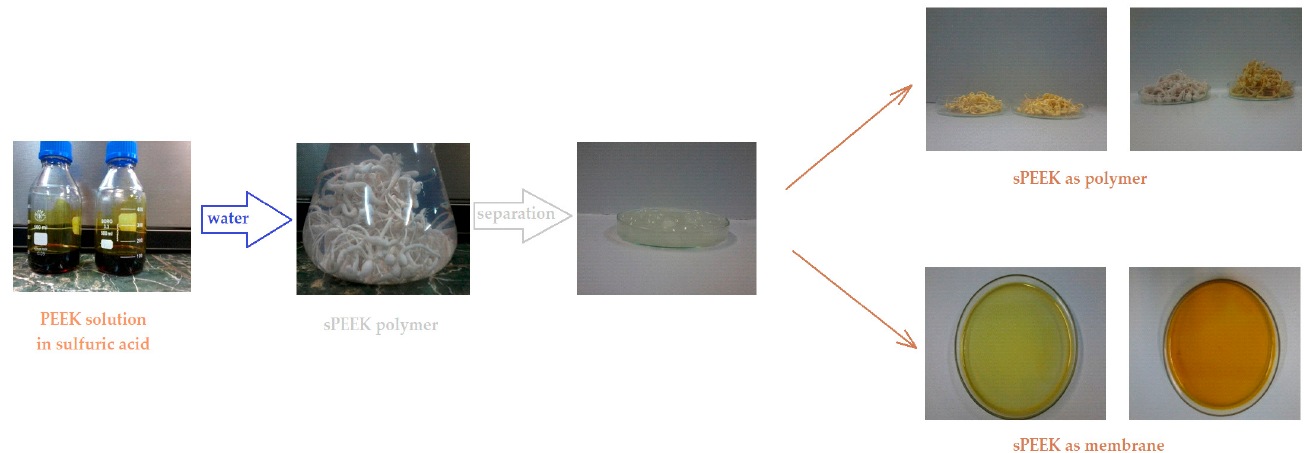
Figure 1. Scheme for obtaining sulfonated poly (ether ether ketone) sPEEK as a polymer and as a membrane from the solution of poly (ether ether ketone) (PEEK) in sulfuric